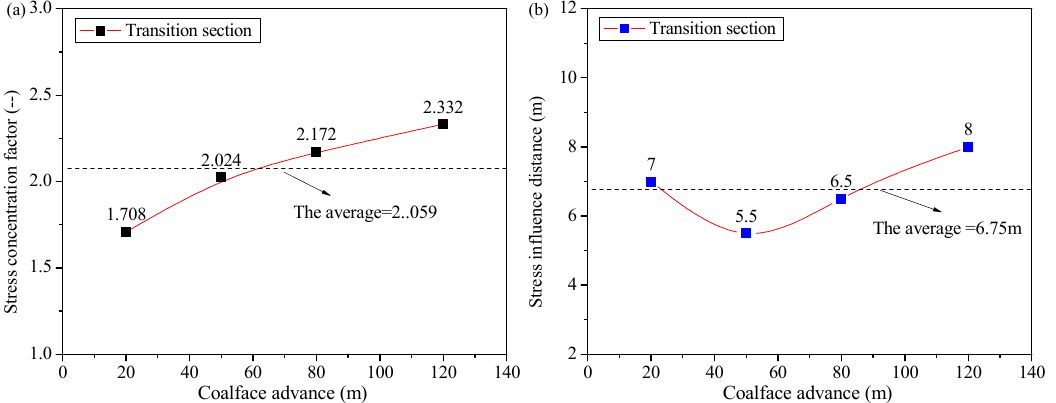
Figure 13. The stress concentration factor and the influence area in the transition section: ( a ) stress concentration factor; ( b ) stress influence area.